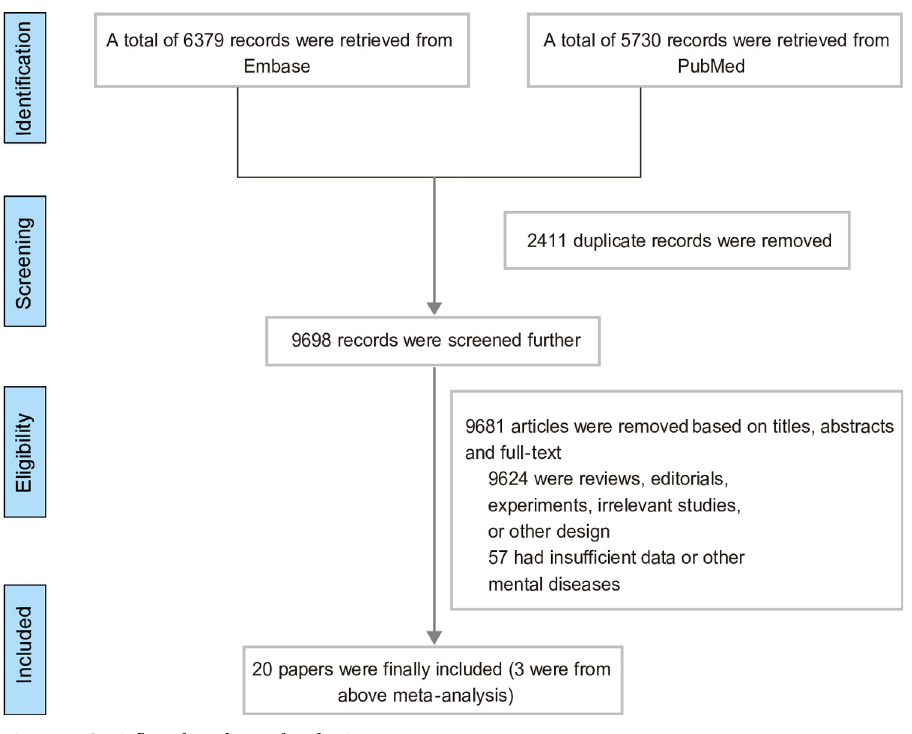
Fig 1. PRISMA flow chart for study